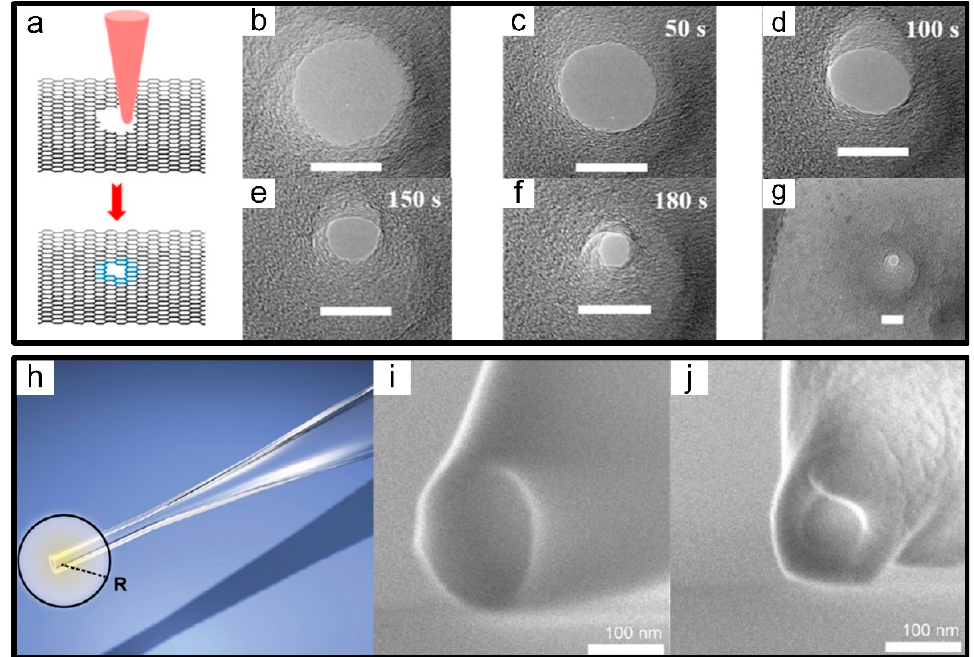
Figure 3. EB-induced material migration. ( a ) Scheme of the graphene nanopores shrinking under electron beam radiation. ( b – g ) Under the electron beam radiation of low current density, the continuous shrinking process of graphene nanopores. The scale bar is 15 nm [49] . ( h ) Scheme of the conical end of the nanocapillary. ( i ) SEM in-lens image of a quartz nanocapillary. ( j ) Shrunken nanocapillary after 14 min of irradiation under constant angle and beam parameters [50] .